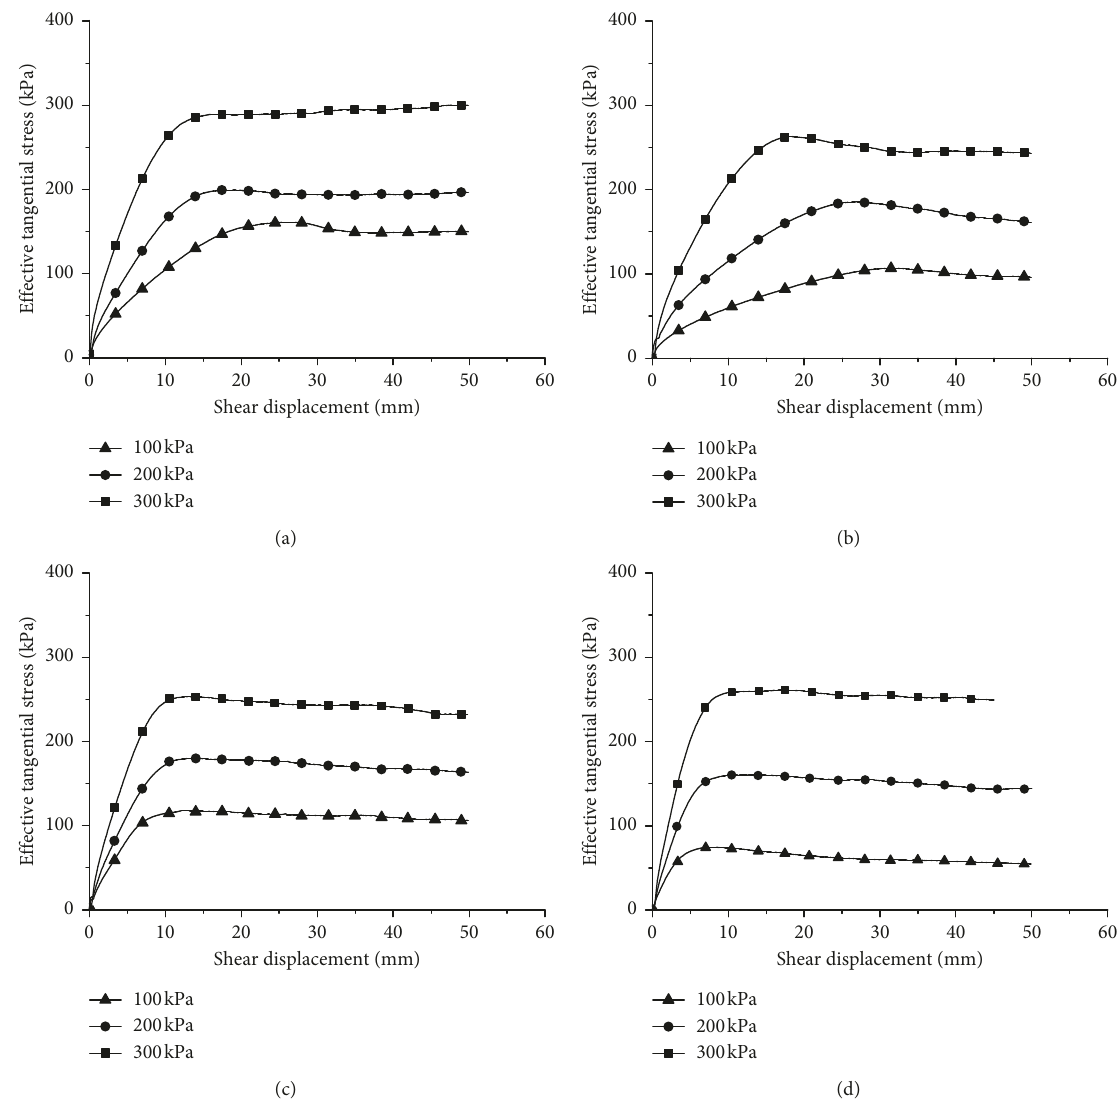
Figure 5: The relationship between tangential stress and shear displacement at L � 300mm, W � 300mm, and H � 300mm: (a) T � 0mm, (b) T � 2mm, (c) T � 4mm, and (d) T � 6